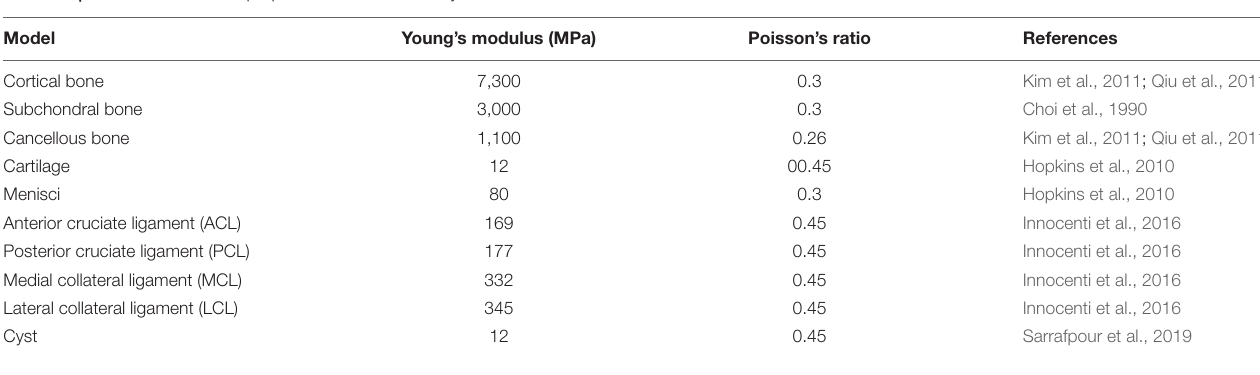
TABLE 1 | Validation of material properties used in this study with